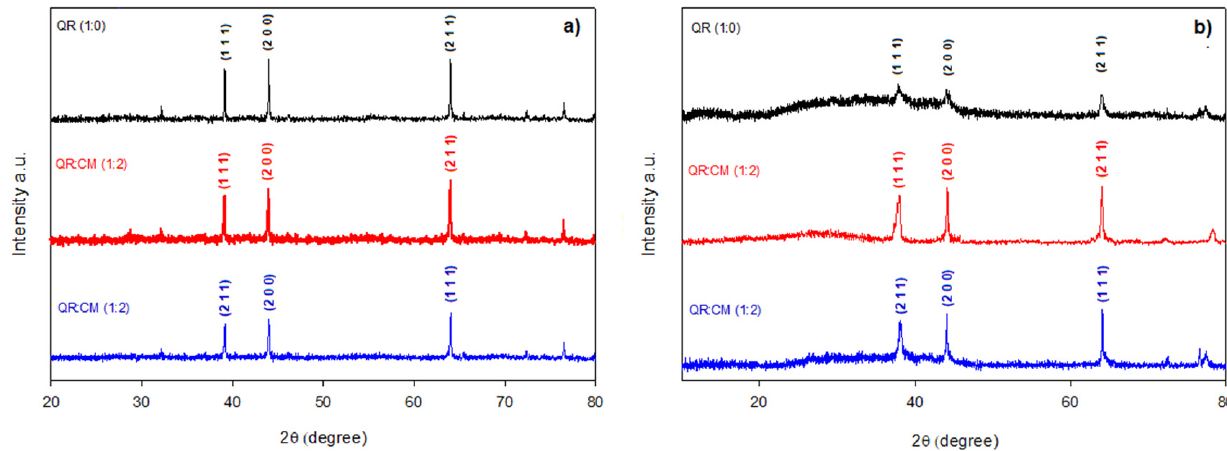
Figure 2. XRD patterns for the best AgNPs systems at different times: ( a ) Day 1 and ( b ) Day 60.